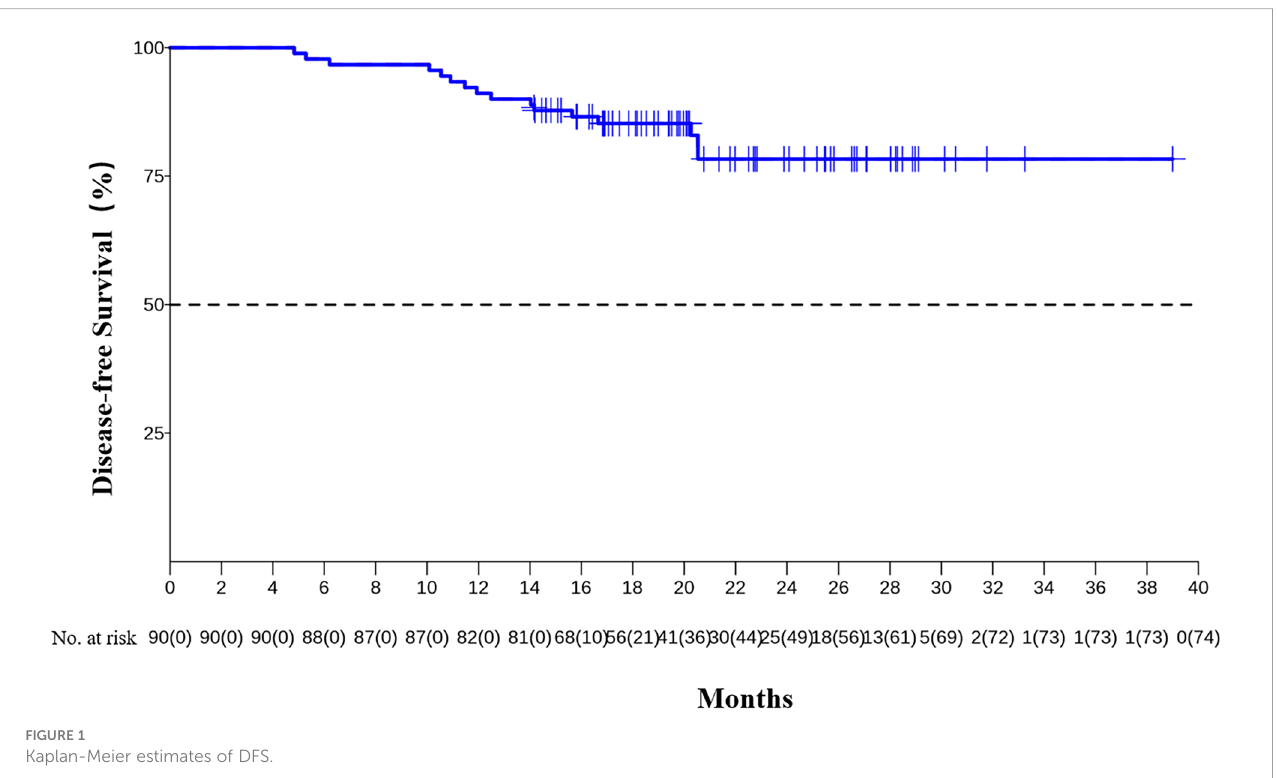
FIGURE 1 Kaplan-Meier estimates of DFS.